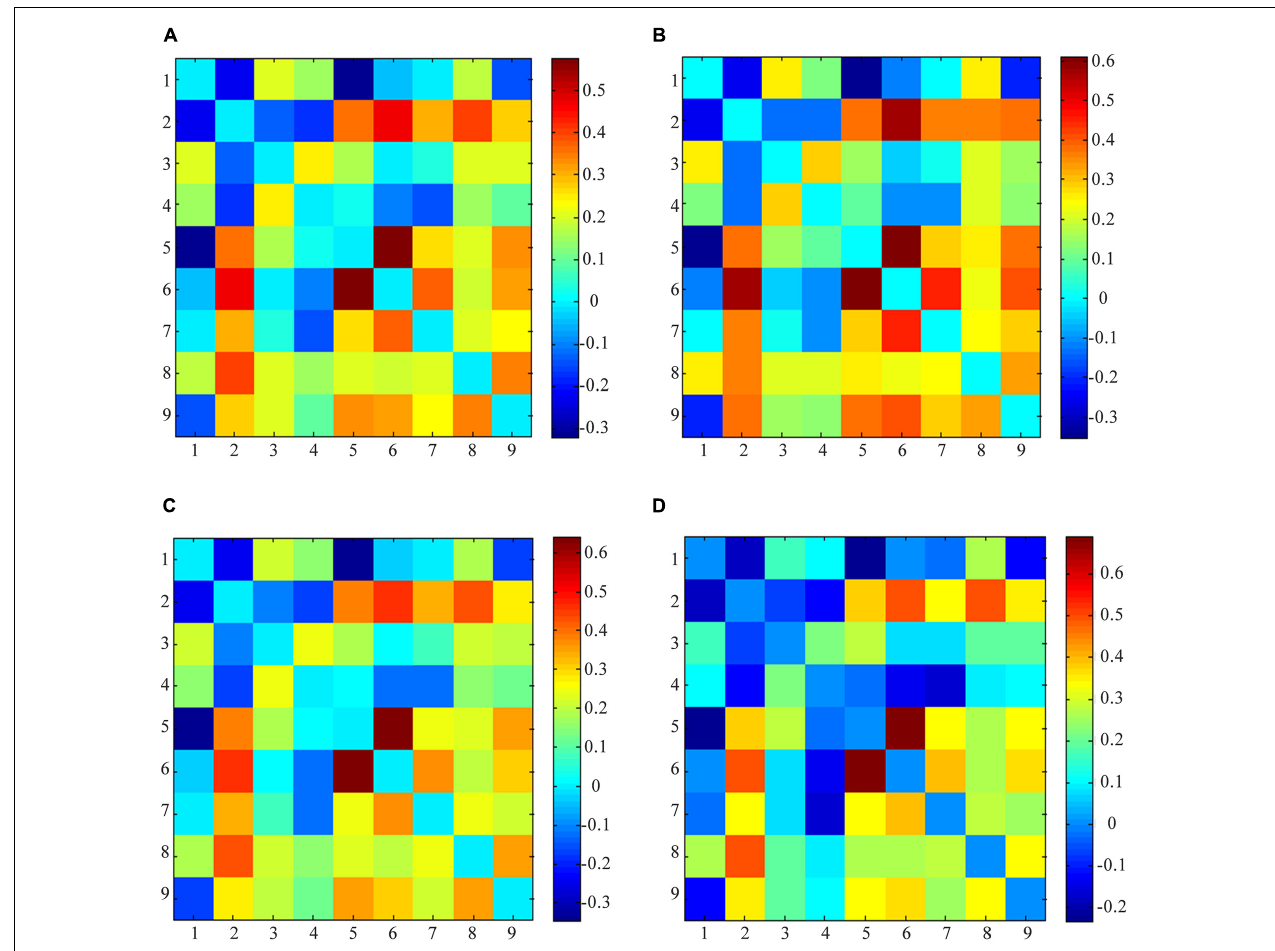
FIGURE 2 | Averaged functional networks activity. (A) Averaged functional networks of all subjects (between IBS-D before acupuncture and HCs); (B) Averaged functional networks of HCs; (C) Averaged functional networks of IBS-D patients before acupuncture; (D) Averaged functional networks of IBS-D patients after acupuncture; (1) anterior default mode network (DMN); (2) auditory network (AN); (3) left frontoparietal Network (LFPN); (4) right frontoparietal network (RFPN); (5) dorsal attention network (DAN); (6) sensorimotor network (SMN); (7) visual network (VN); (8) ventral attention network (VAN); (9) salience network (SN). TABLE 2 | The clinical outcomes of IBS-D patients before and after acupuncture treatment (Mean ± SD). Item Before